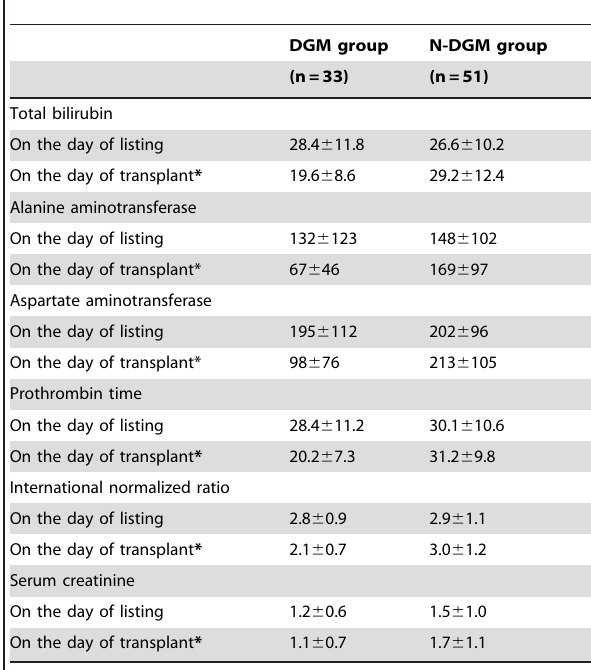
Table 1. Changes of biochemistry parameters after all sessions of ALSS